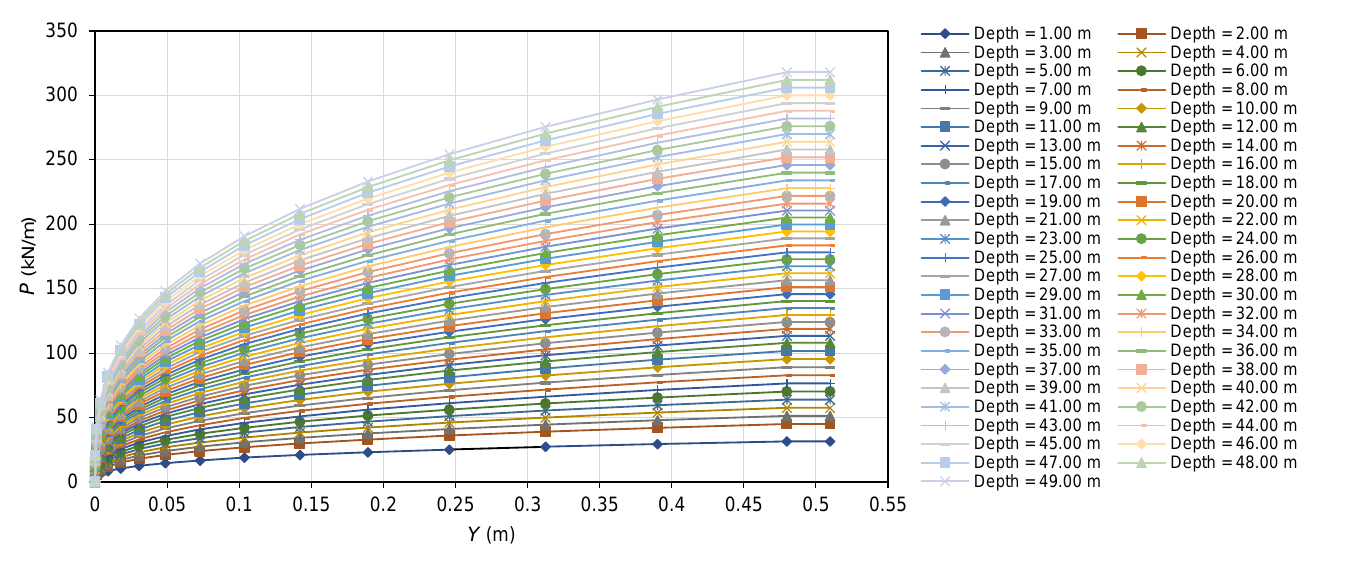
Figure 8. P-Y curves for Pile 3 (Ø 1200 mm).